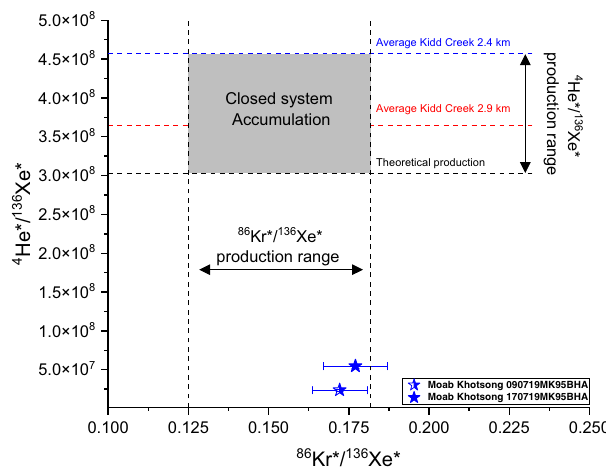
Fig. 3 Radiogenic excesses of 4 He*, 86 Kr*, and 136 Xe* for Moab Khotsong brine compared to production ratios, based on predicted values from uranium decay. The 86 Kr*/ 136 Xe* production range is shown between the vertical black hatched lines, and the theoretical 4 He*/ 136 Xe* (between horizontal black hatched line) from Ballentine and Burnard 30 . For additional context, average 4 He*/ 136 Xe* production ranges are plotted for fracture fl uids from two depths at Kidd Creek, Canada (blue and red hatched lines), which is considered representative of a closed system given the good agreement between 4 He*, 21 Ne*, 40 Ar*, and 136 Xe*-derived residence times 2,14 . The shaded grey box then suggests the space that de fi nes a closed system. Both Moab Khotsong samples (blue stars) reveal signi fi cant depletion in 4 He*/ 136 Xe* with respect to closed system accumulation, but retain 86 Kr*/ 136 Xe* ratios in line with in situ fi ssiogenic production from uranium. As atmospheric addition serves to reduce 86 Kr* and 136 Xe* proportionally, both samples preserve in situ radiogenic ratios (i.e. this ratio is insensitive to air contamination during sampling seen for sample 090719MK95BHA). Such a pattern of depletion in the light noble gases 4 He* (and 21 Ne*) with respect to their heavy noble gas counterparts is consistent with diffusive loss. Error bars incorporate propagated analytical uncertainty of 1 σ